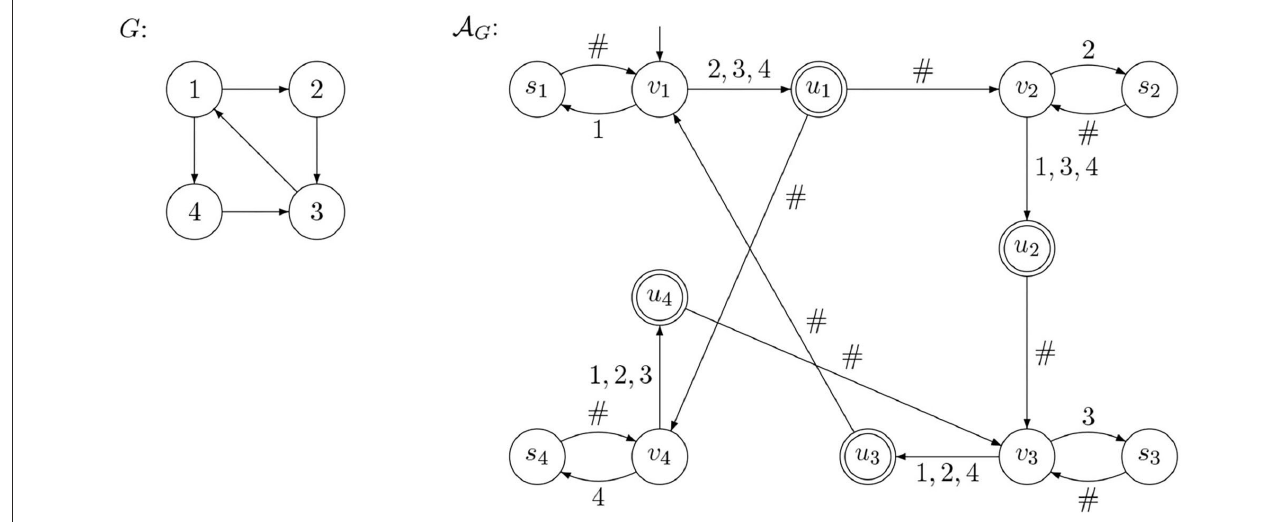
FIGURE2 Reduction from the Hamiltonian-cycle